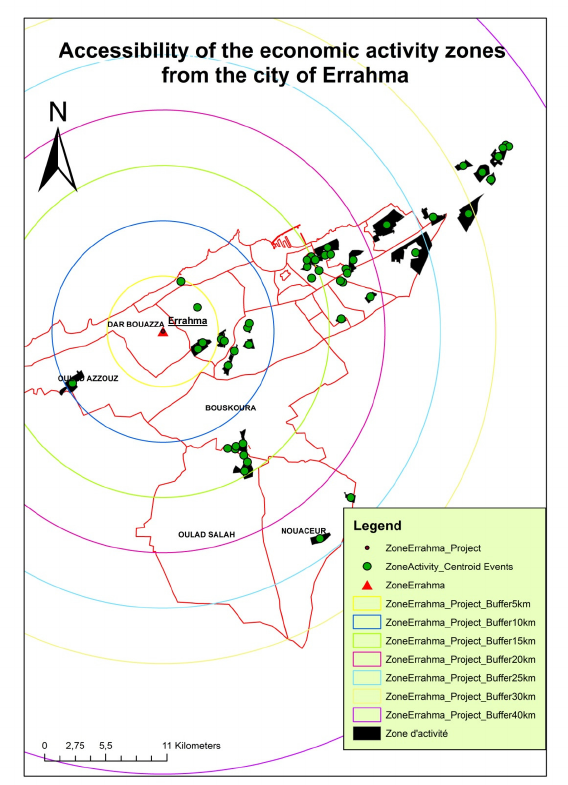
Figure 6: Accessibility of the economic activity zones from the city of